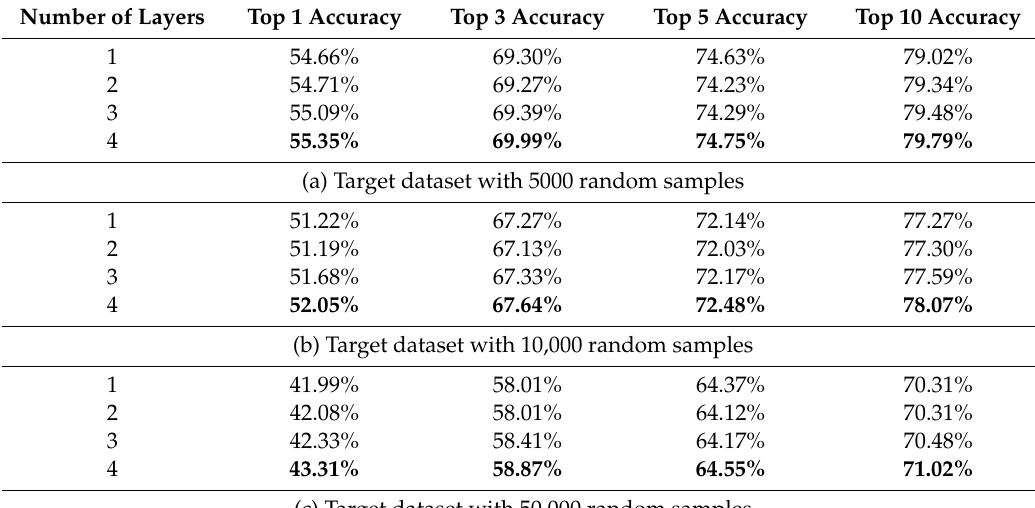
Table 3. Changes in the mapping accuracy of MARIE (BioBERT + R / O with α = 0.8) with respect to the number of BioBERT layers used to represent an embedding